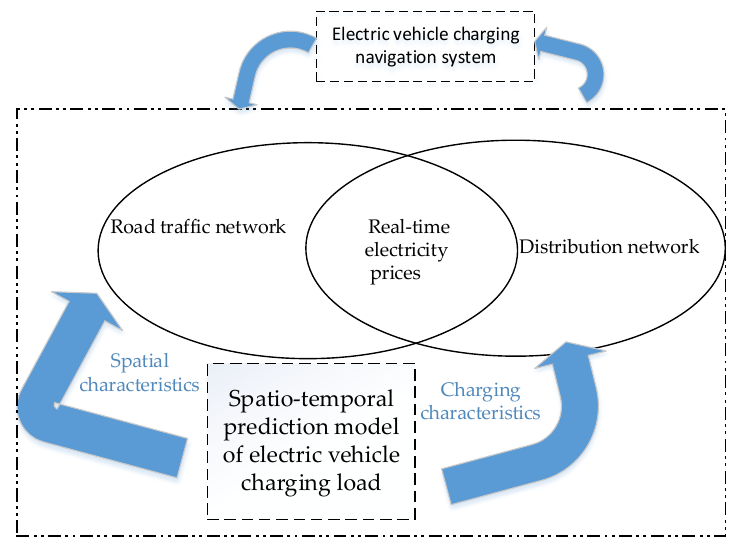
Figure 1. Relationship between subsystems.